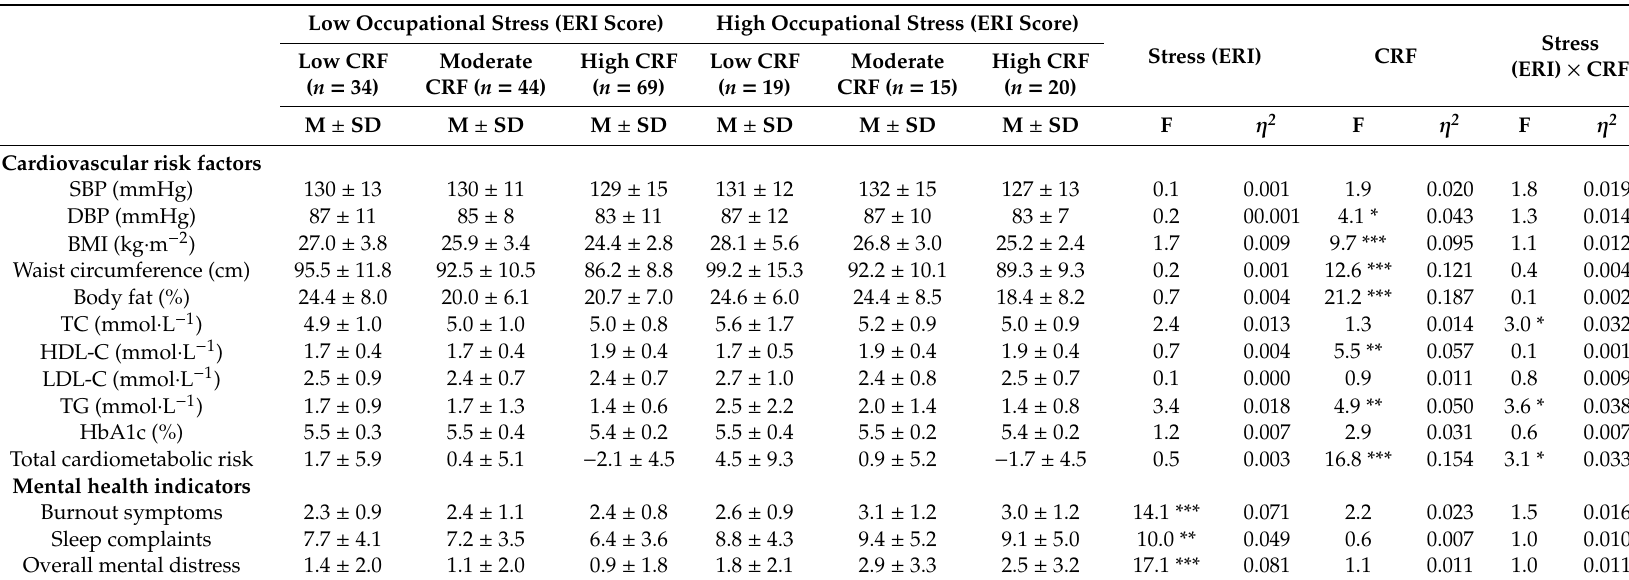
Table 3. Di ff erences in cardiometabolic risk factors, and mental health indicators, dependent on participants’ levels of CRF and perceived occupational stress (as assessed via the e ff ort-reward imbalance [ERI]